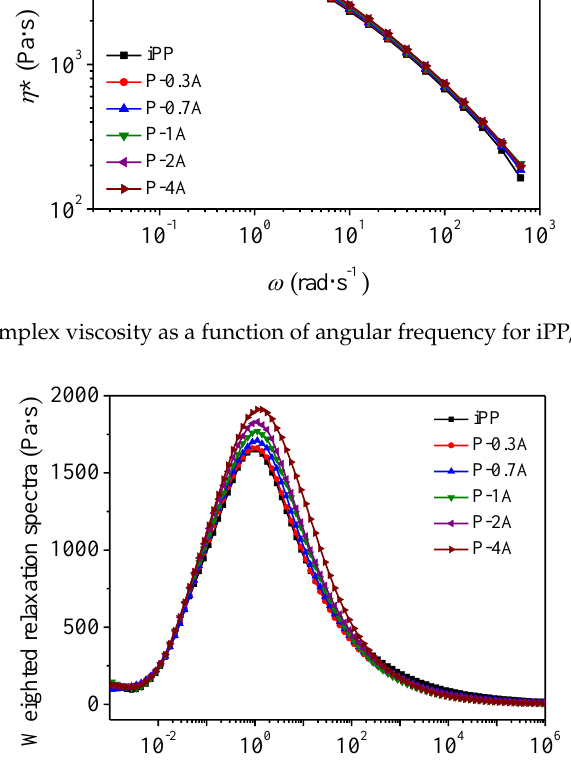
Figure 4. Weighted relaxation spectra of iPP/ABS blends at 190 °C.